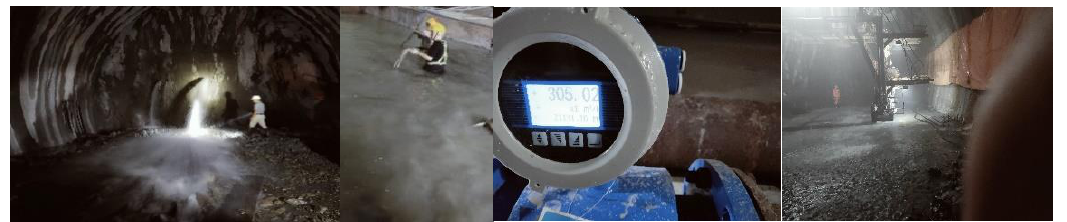
Figure 8. Drainage and flow monitoring.